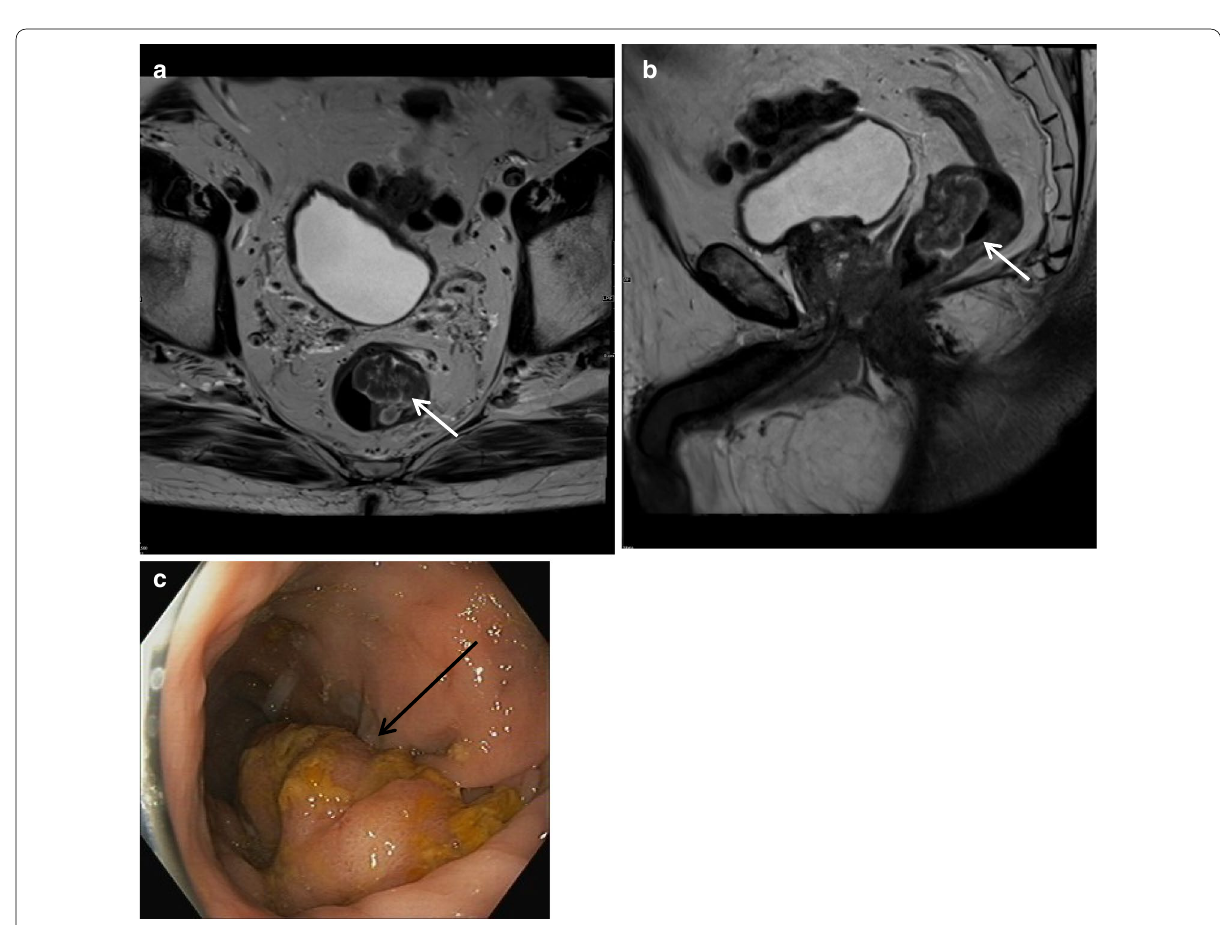
Fig. 23 Rectal villous adenoma a Axial and ( b ) sagittal T2W images show a large lobulated polypoid mass within the lower rectum at 2 cm from anal verge (white arrow). The mass shows thick T2 hyperintense layer along the surface with heterogeneous intermediate to high-signal intensity within the lesion. c Colonoscopy and polypectomy confirmed villous/ tubulovillous adenoma (black arrow) with low-grade